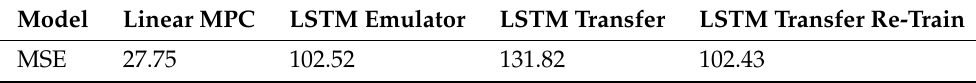
Table 3. Mean squared error (measured temperature vs. temperature